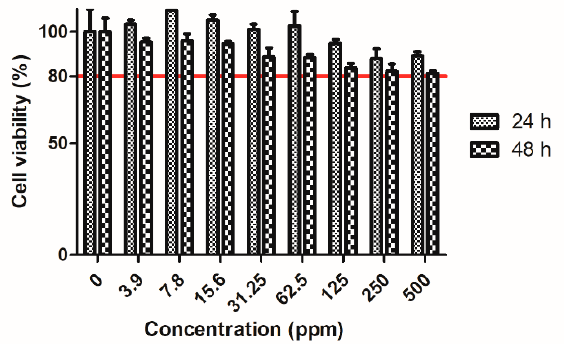
Figure 2. MTT assay of CT-26 cells incubated with various concentrations of Au@HSANPs. Insignificant cytotoxicity of Au@HSANPs was noticed after incubation at a concentration up to 500 ppm for 24 or 48 h. The cell viabilities of the CT-26 cells were retained >80%, as compared with the control group.